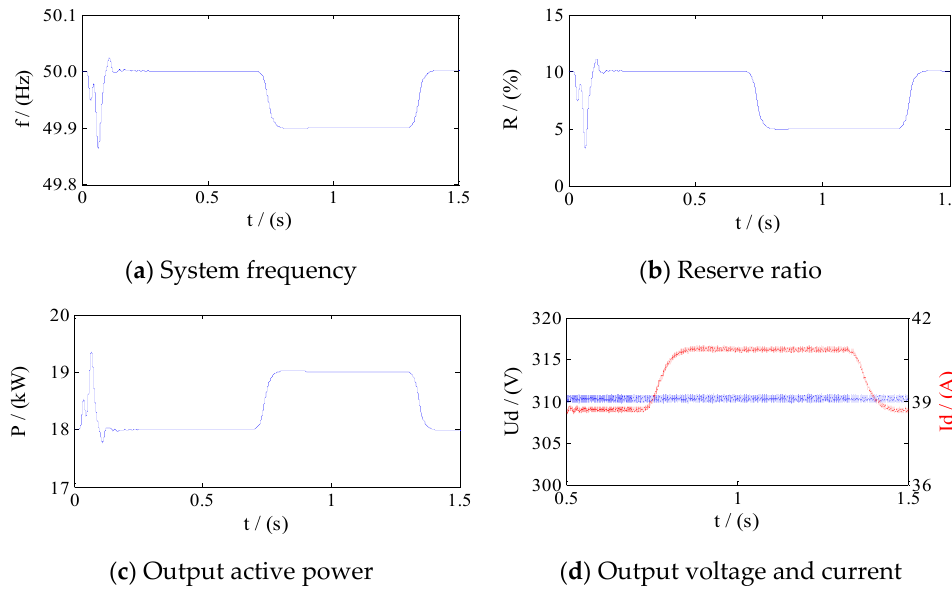
Figure 8. System output waveform when frequency decreases by 0.1 Hz.